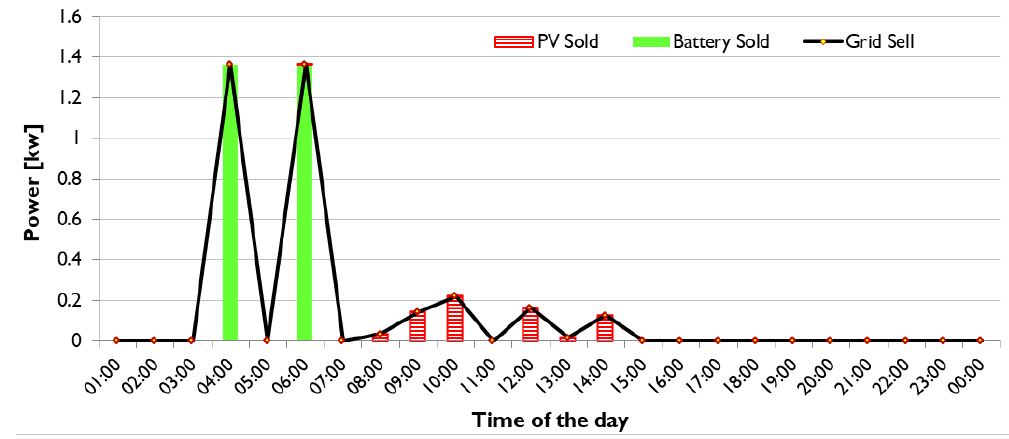
Figure 15. The decomposition of injected power to the grid with PV and battery for sample summer case.